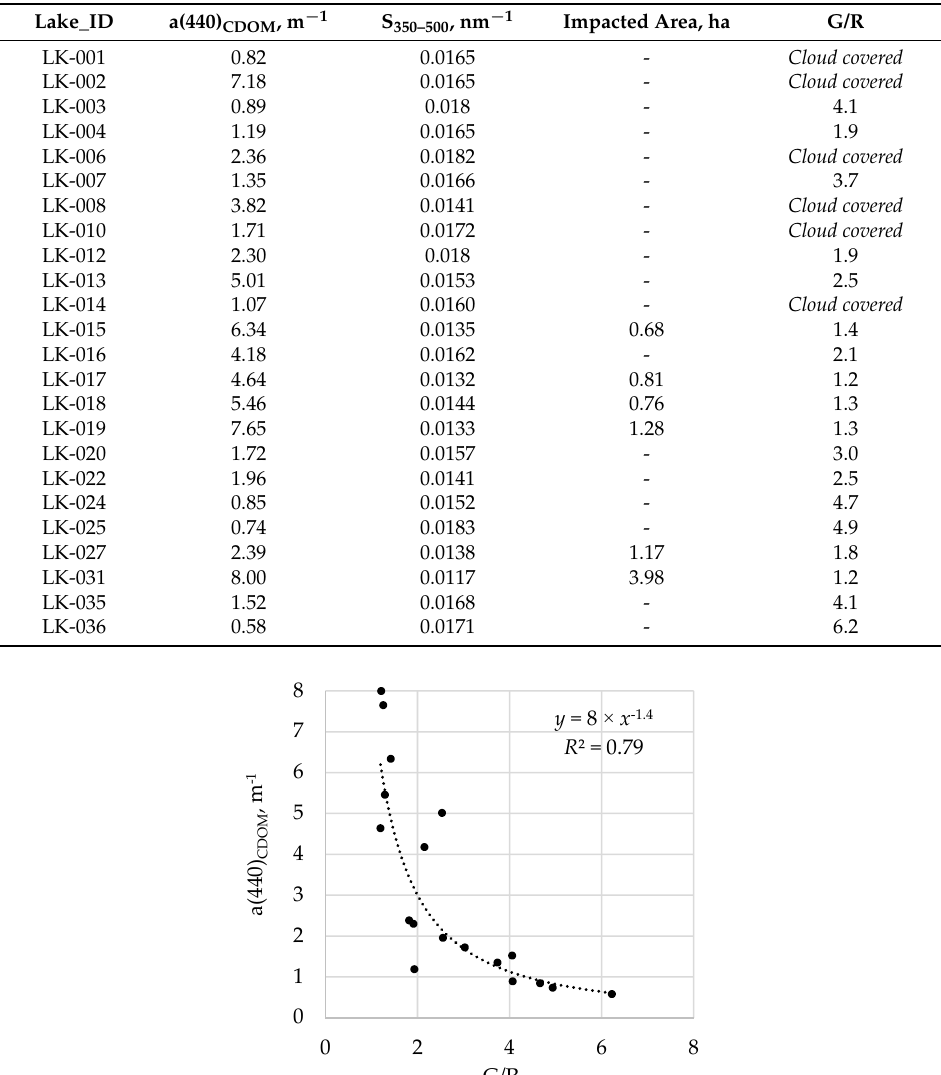
Table 4. Results of in-situ a(440) CDOM and S 350–500 , catchment area impacted by thermocirques, green (G)/red (R) reflectance ratio of satellite images.